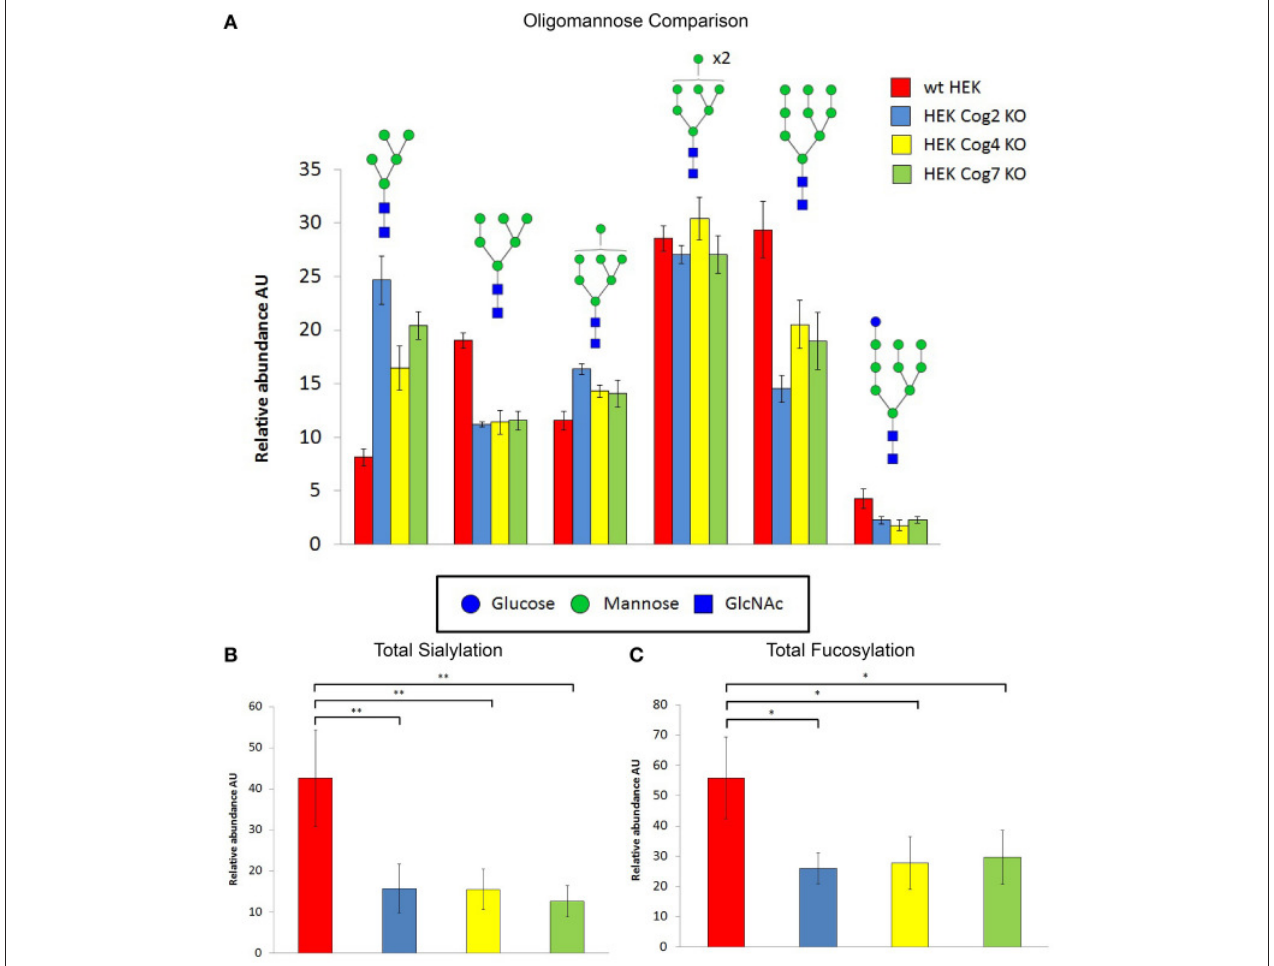
FIGURE 10 | COG KO cells have global changes in N -linked glycans structures. N -glycans prepared from cell lysates were profiled by mass spectrometry. The normalized intensities for individual glycans grouped into different classes as indicated were summed. Error bars show SEM for n = 4 (WT, Cog2KO), n = 5 (Cog4KO), n = 8 (Cog7 KO). (A) Oligomannose composition changes in KO cells vs. WT cells. (B) Sialyation changes in KO cells vs. WT cells. ** denotes p < 0.01. (C) Fucosylation changes in KO cell vs. WT cells * denotes p < 0.05. For (B,C) one-way ANOVA with a Sidak-Holm post hoc statistical significance test was